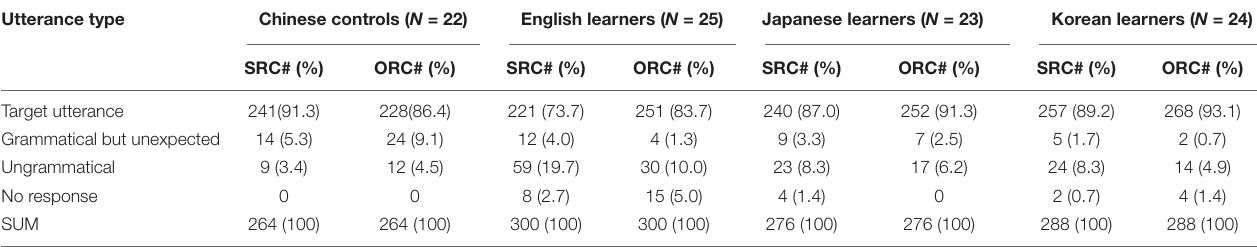
TABLE 3 | Utterance types produced by all groups of participants.